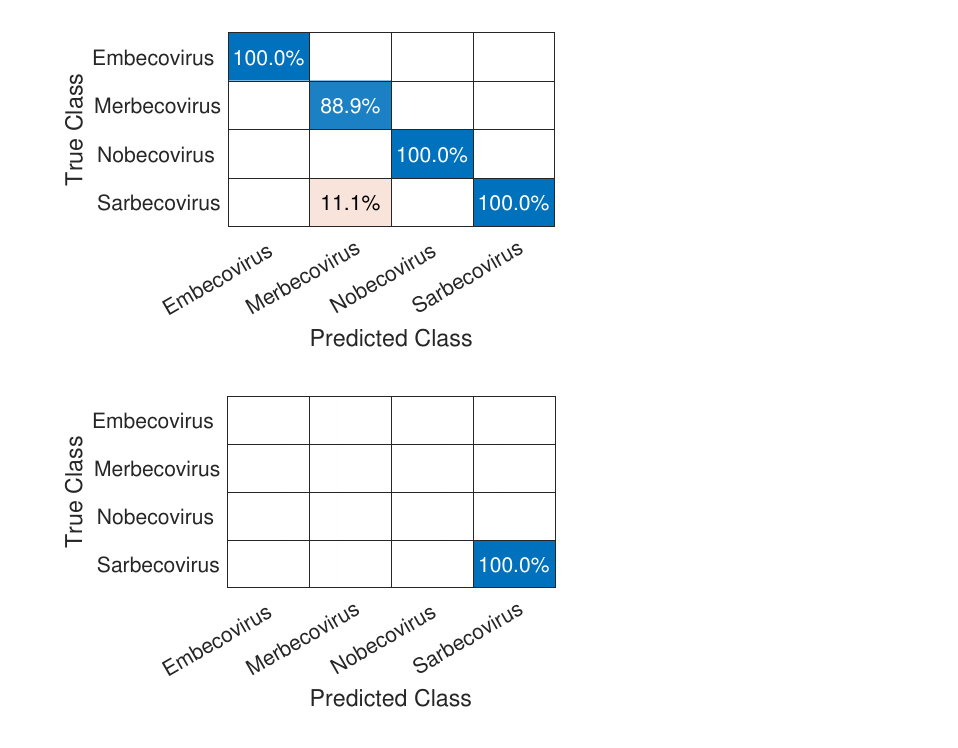
Figure 11. Confusion matrices for CNN validation using the subgenus samples within the Beta- coronavirus genus ( top ) and, for SARS-CoV-2 classification, in its correct subgenus, Sarbecovirus ( bottom ). Table 3. Validation accuracy and validation error results for the 4 experiments